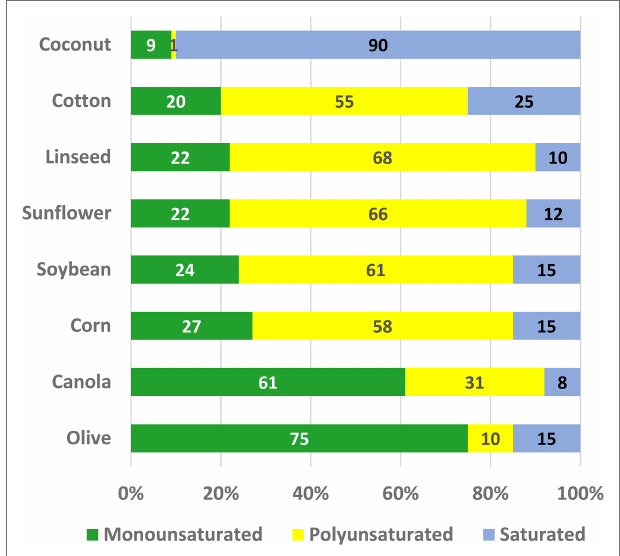
FIGURE 1 | The oil compositions of some major crops. The percentages of monounsaturated (mainly 18:1), polyunsaturated (18:2 + 18:3), and saturated (16:0 + 18:0) fatty acids are